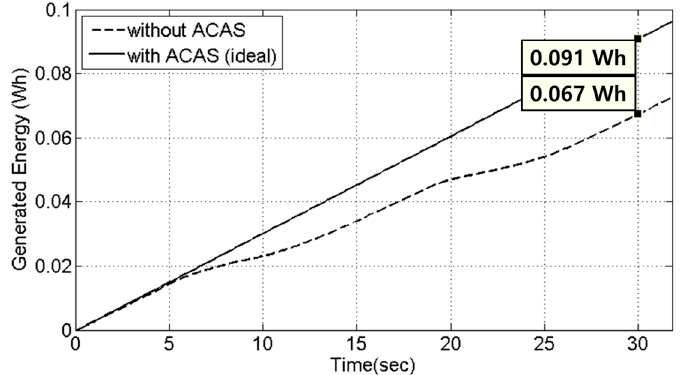
Figure 28. Comparison of estimated energy accumulated by a vehicle with ACAS and a vehicle without ACAS (based on generated power in the load coil shown in Figure 24).